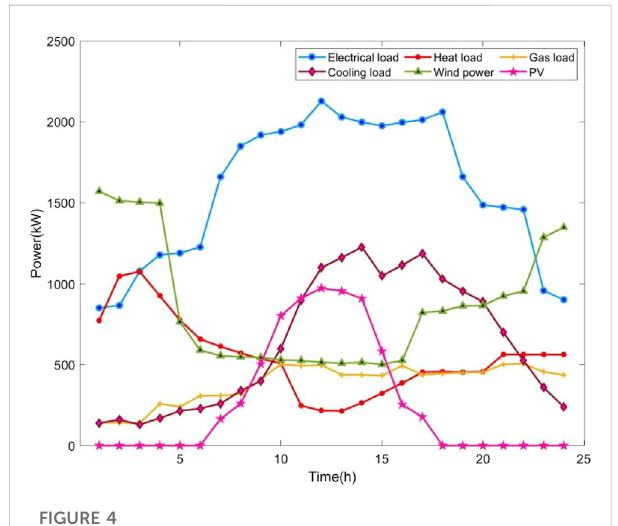
FIGURE 4 Prediction curve of wind power, photovoltaic, and multi-load in IES.